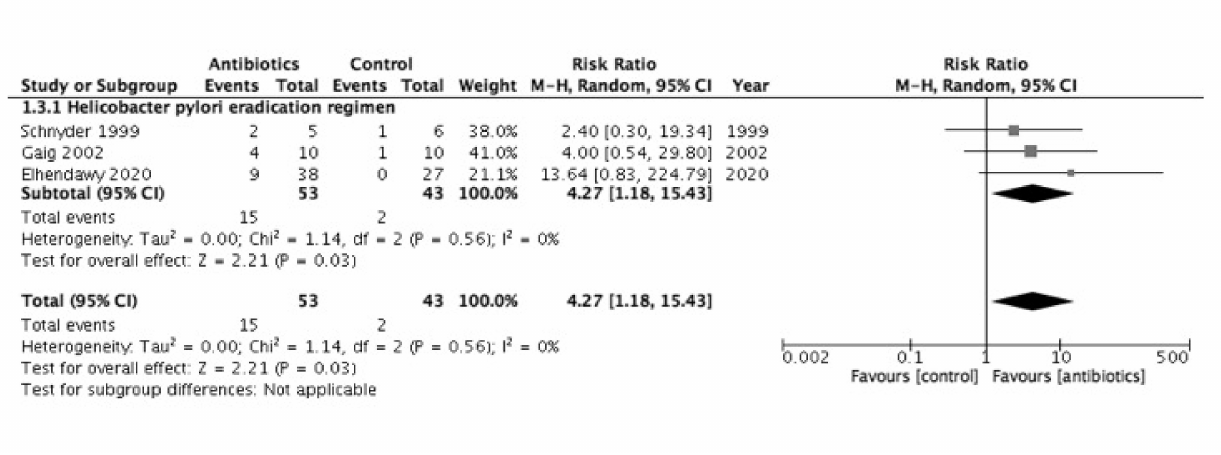
Figure A3. Forest plot of the remission rate excluding studies with a high overall risk of bias. Table A1. Quality scores for the eligibility studies for clinical improvement.